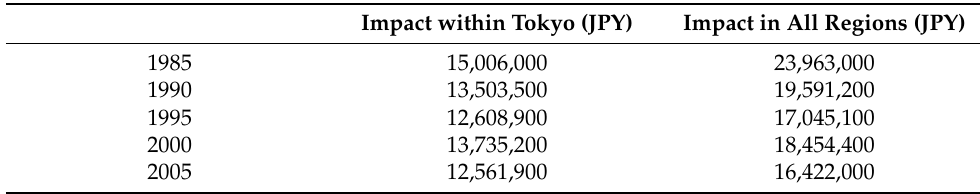
Table 1. Total output in Tokyo and in all regions. Impact within Tokyo (JPY) Impact in All Regions